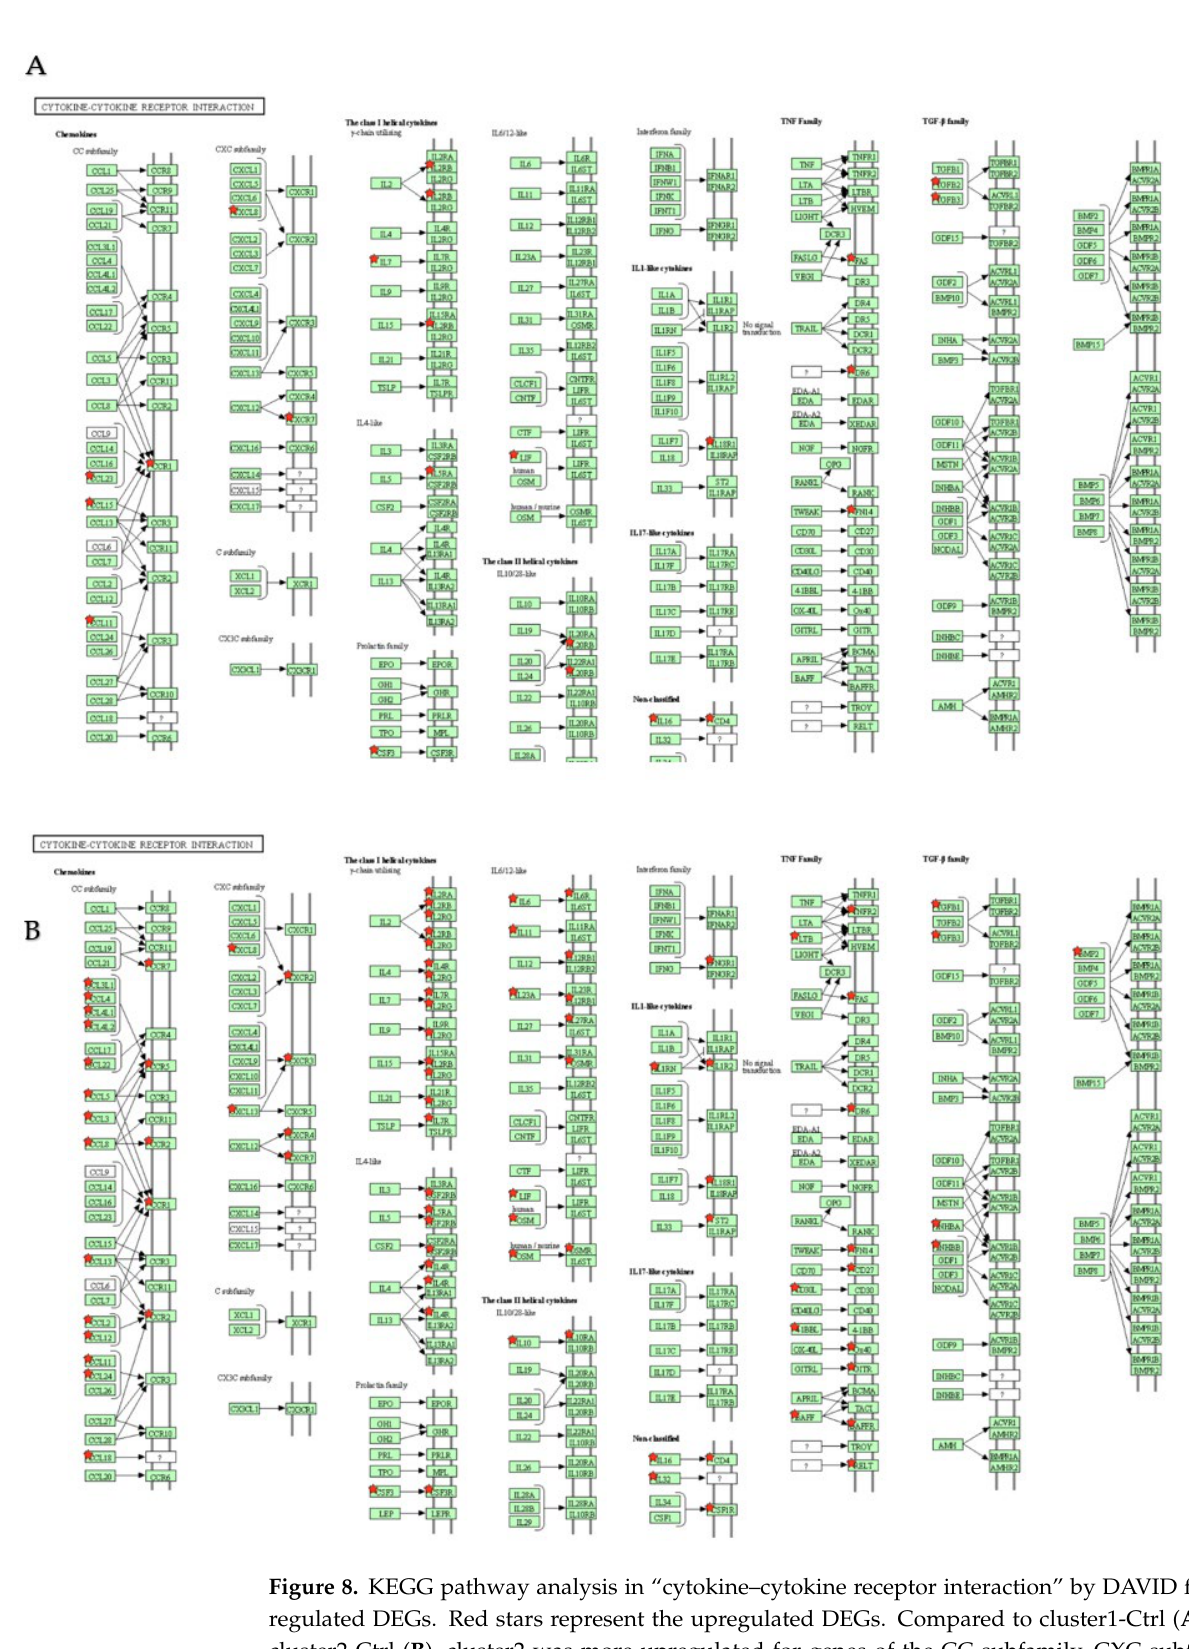
Figure 8. KEGG pathway analysis in “cytokine–cytokine receptor interaction” by DAVID for up- regulated DEGs. Red stars represent the upregulated DEGs. Compared to cluster1-Ctrl ( A ) and cluster2-Ctrl ( B ), cluster2 was more upregulated for genes of the CC subfamily, CXC subfamily, gamma-chain utilizing, IL-4-like, IL6/12-like, IL-1-like cytokine, and TNF